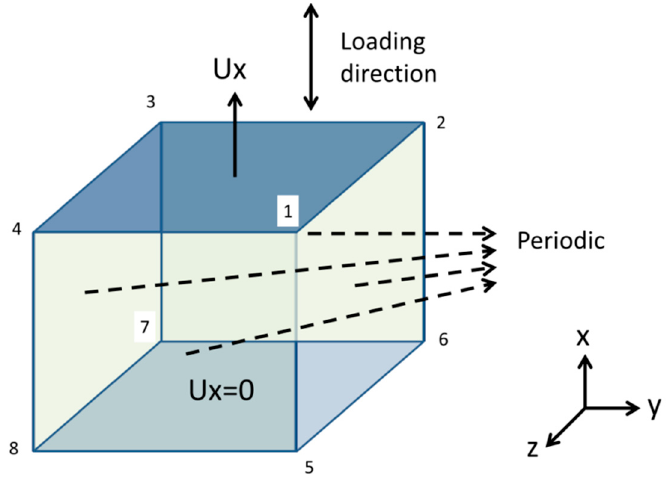
Figure 1. Boundary conditions for the representative volume elements (RVEs) [23].